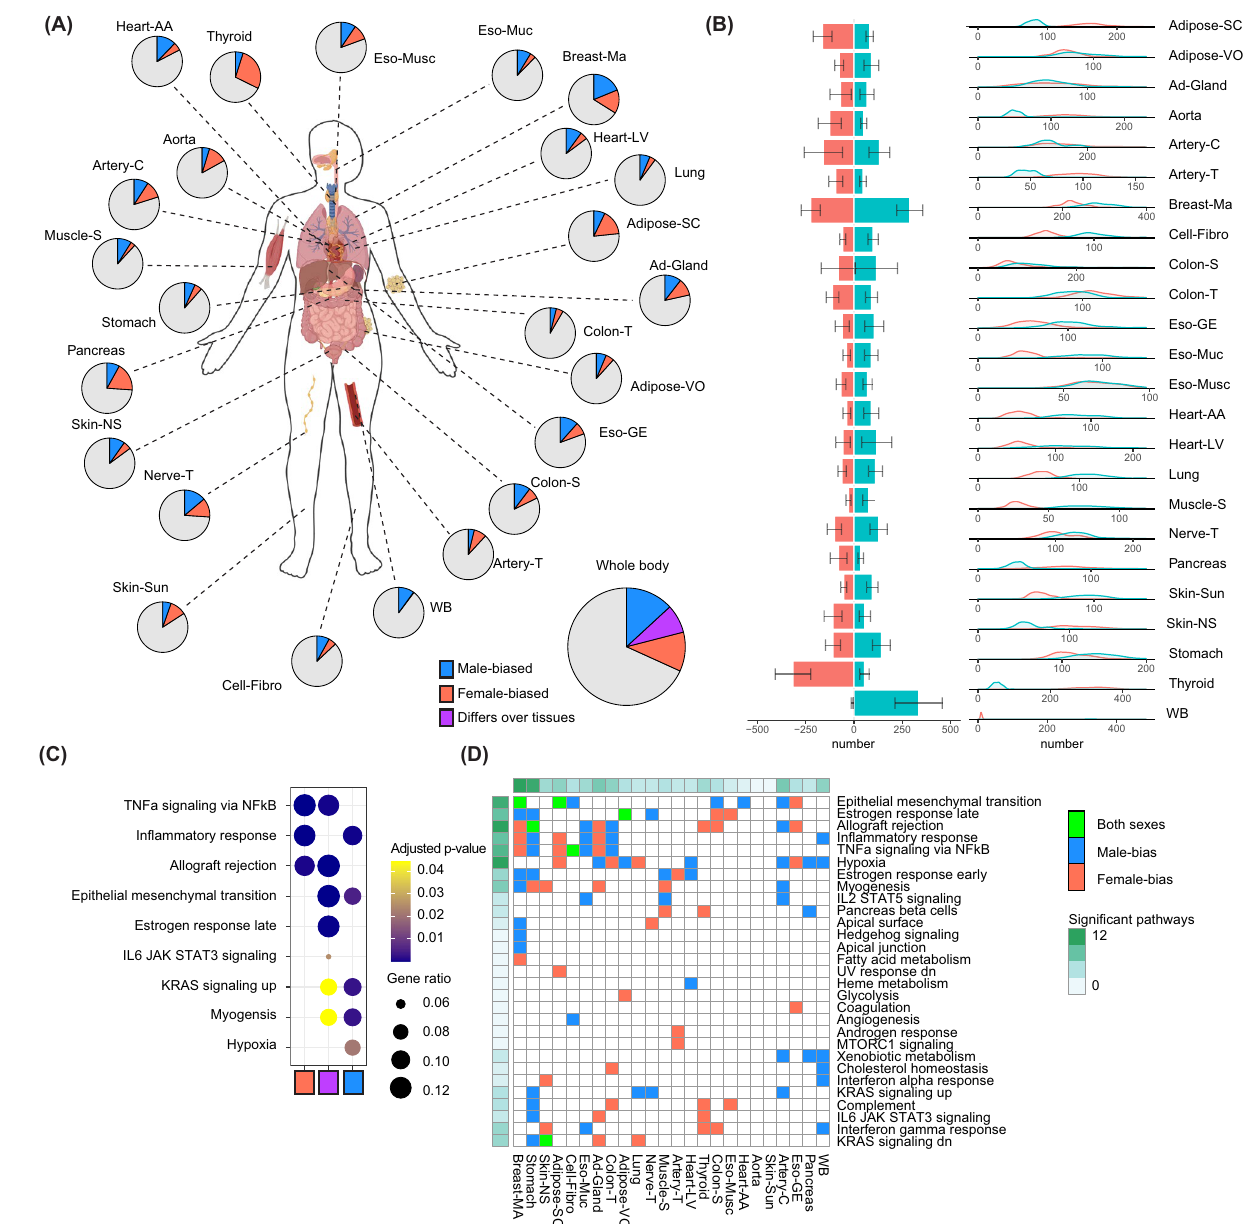
Figure 2. A whole-body map of sex differences in gene co-expression. ( A ) A cartoon of the human body is shown with the tissues that are used in our study. For each tissue, the number of genes that are either male- (blue) or female-biased (red) are shown in a piechart. The bigger piechart shows all genes combined over all tissues, with purple indicating genes that differ in bias over multiple tissues. ( B ) The exact number of genes that are either male- or female-biased per tissue is shown in a barplot with a 95% confidence interval as generated by permutation analysis. Adjacent density plots show the distribution of number of sex-biased genes over the different permutations. ( C ) A dotplot is shown for the top hallmark enrichments for the whole-body genes that are female-, male- or either sex-biased. Color indicates p- value, while size of the dot indicates gene ratio. ( D ) A heatmap is shown that indicates significantly enriched hallmarks over the different tissue. The color within the heatmap indicates whether the enrichment is significant in female-biased genes (red), male-biased genes (blue) or both (green) for that tissue-hallmark combination. Significant pathways indicates the total number of significant enrichments for the different tissues and the different